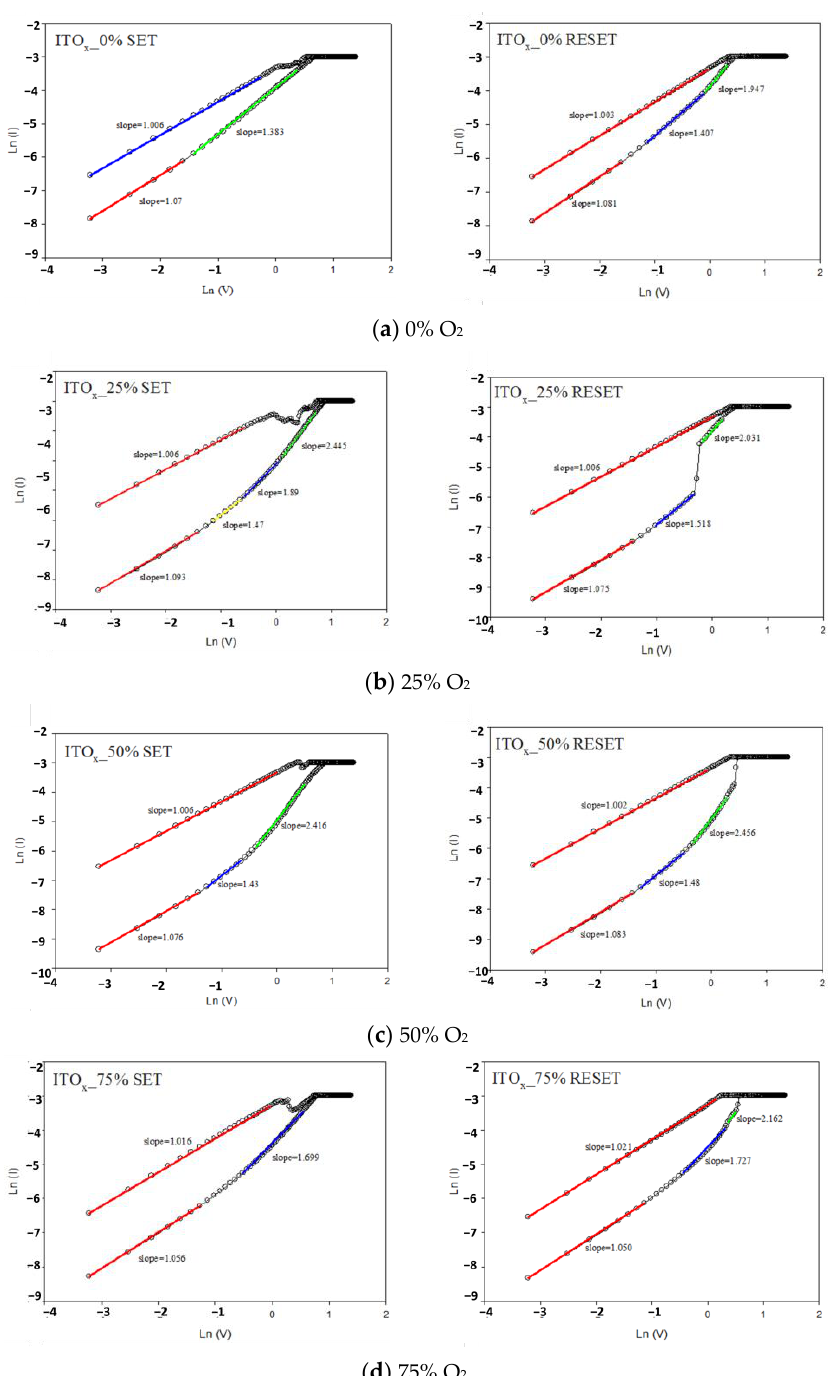
Figure 10. The Ln (I)-Ln (V) plot of ITO/ITO X /ITO RRAM for different oxygen growth parameters (RF power of 50 W) for ( a ) 0%( b ) 25%( c ) 50%, and ( d ) 75%.